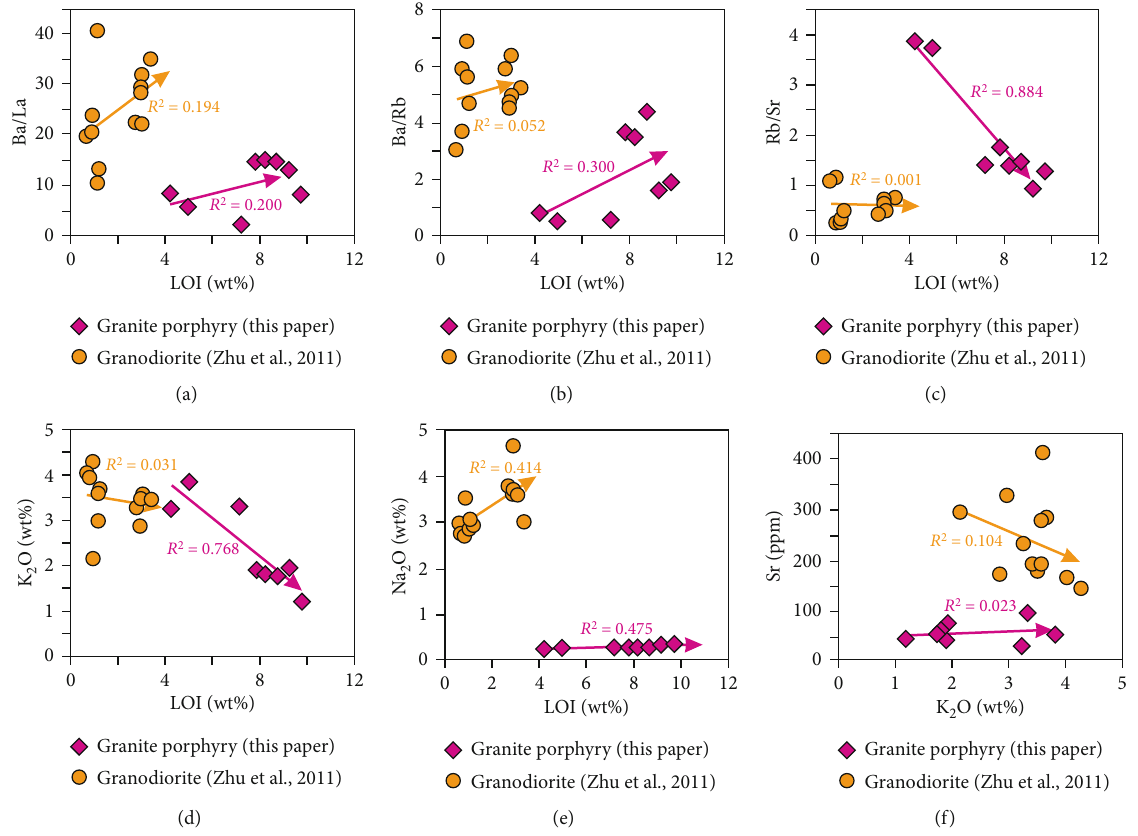
Figure 16: The diagram Ba/La, Ba/Rb, Rb/Sr, K deposit, Yunnan, China (after Wang et al., 2019